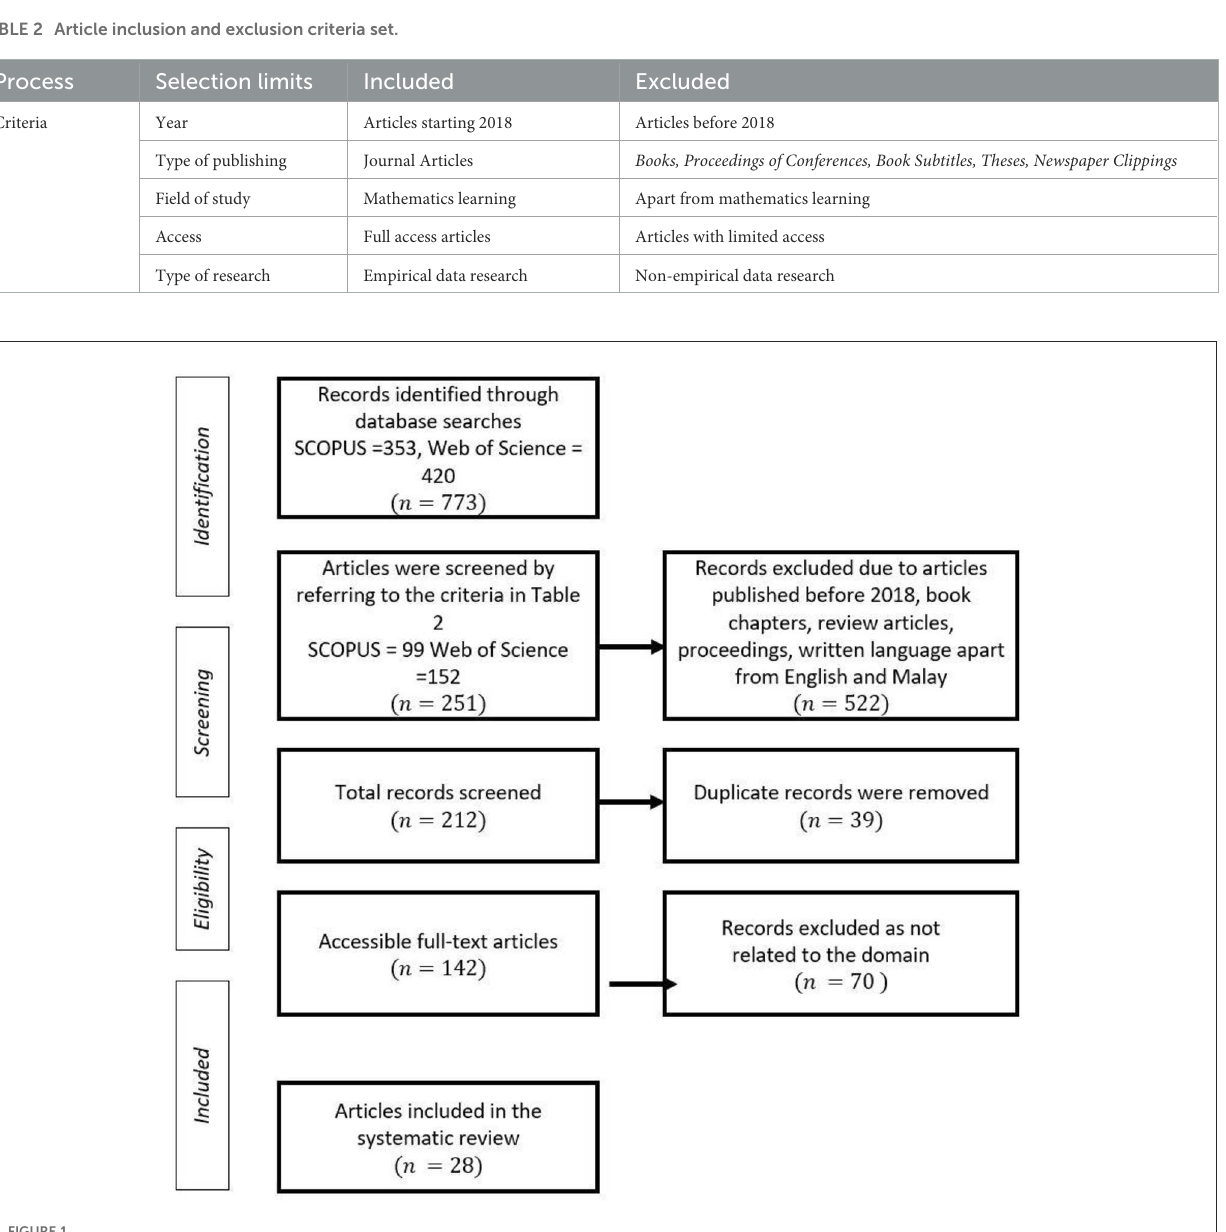
Ting et al., 2019; Baek and and Touati, 2020; Barros et al., 2020; Jiménez et al., 2020; Ramani et al., 2020; Scalise et al., 2020; Vanbecelaere et al., 2020; Ilhan, 2021; Juric et al., 2021; Kärki et al., 2021; Liu et al., 2021; Malliakas et al., 2021; Zabala-Vargas et al., 2021; Thai et al., 2022). Six studies (21%)